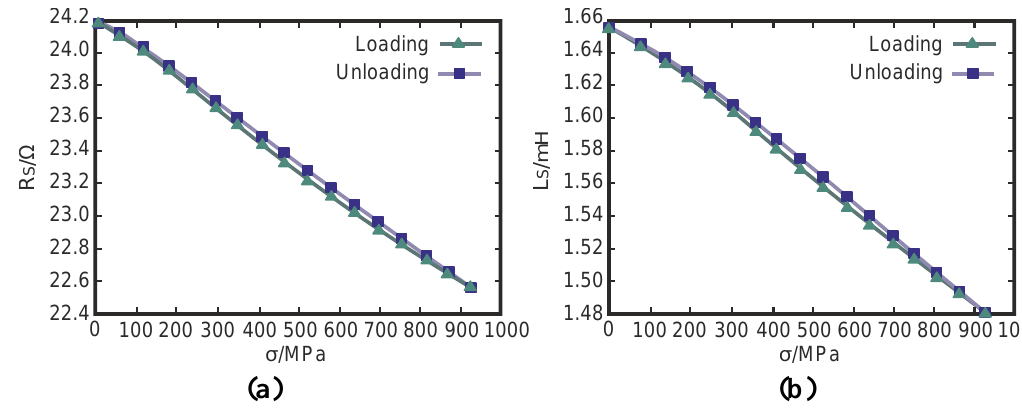
Figure 7. (a) Resistance as a function of mechanical stress (adapted from [21]). (b) Inductance as a function of mechanical stress (adapted from [21]).